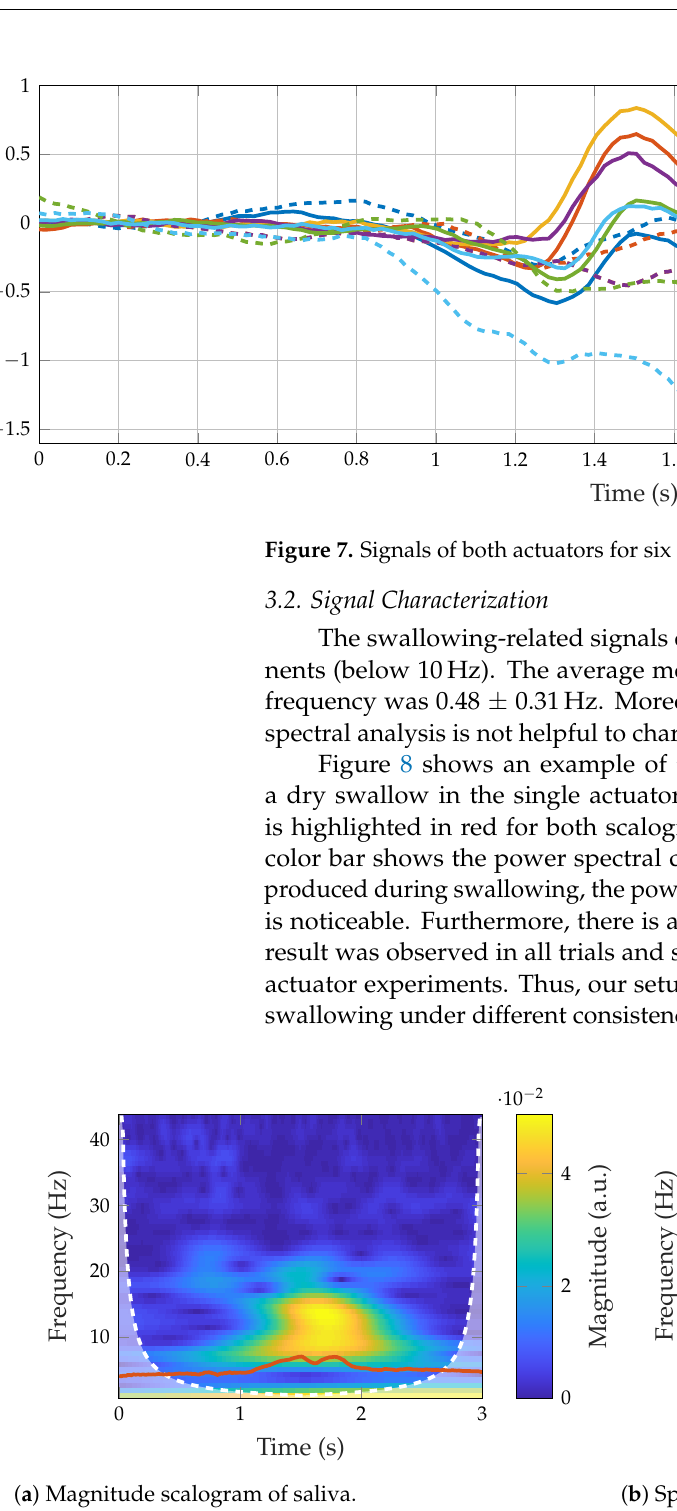
Figure 8. Spectral examples of the saliva-related signal in the single actuator